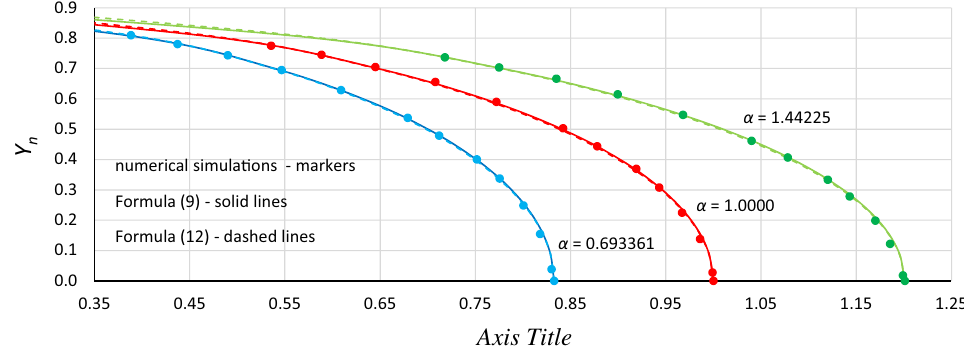
Figure 11. The consistency of analytical formulas (9)—solid line and (12)—dashed line with the results of numerical simulations (markers) for α = 0.693361 (blue), α = 1.0000 (red) and α = 1.44225 (green).